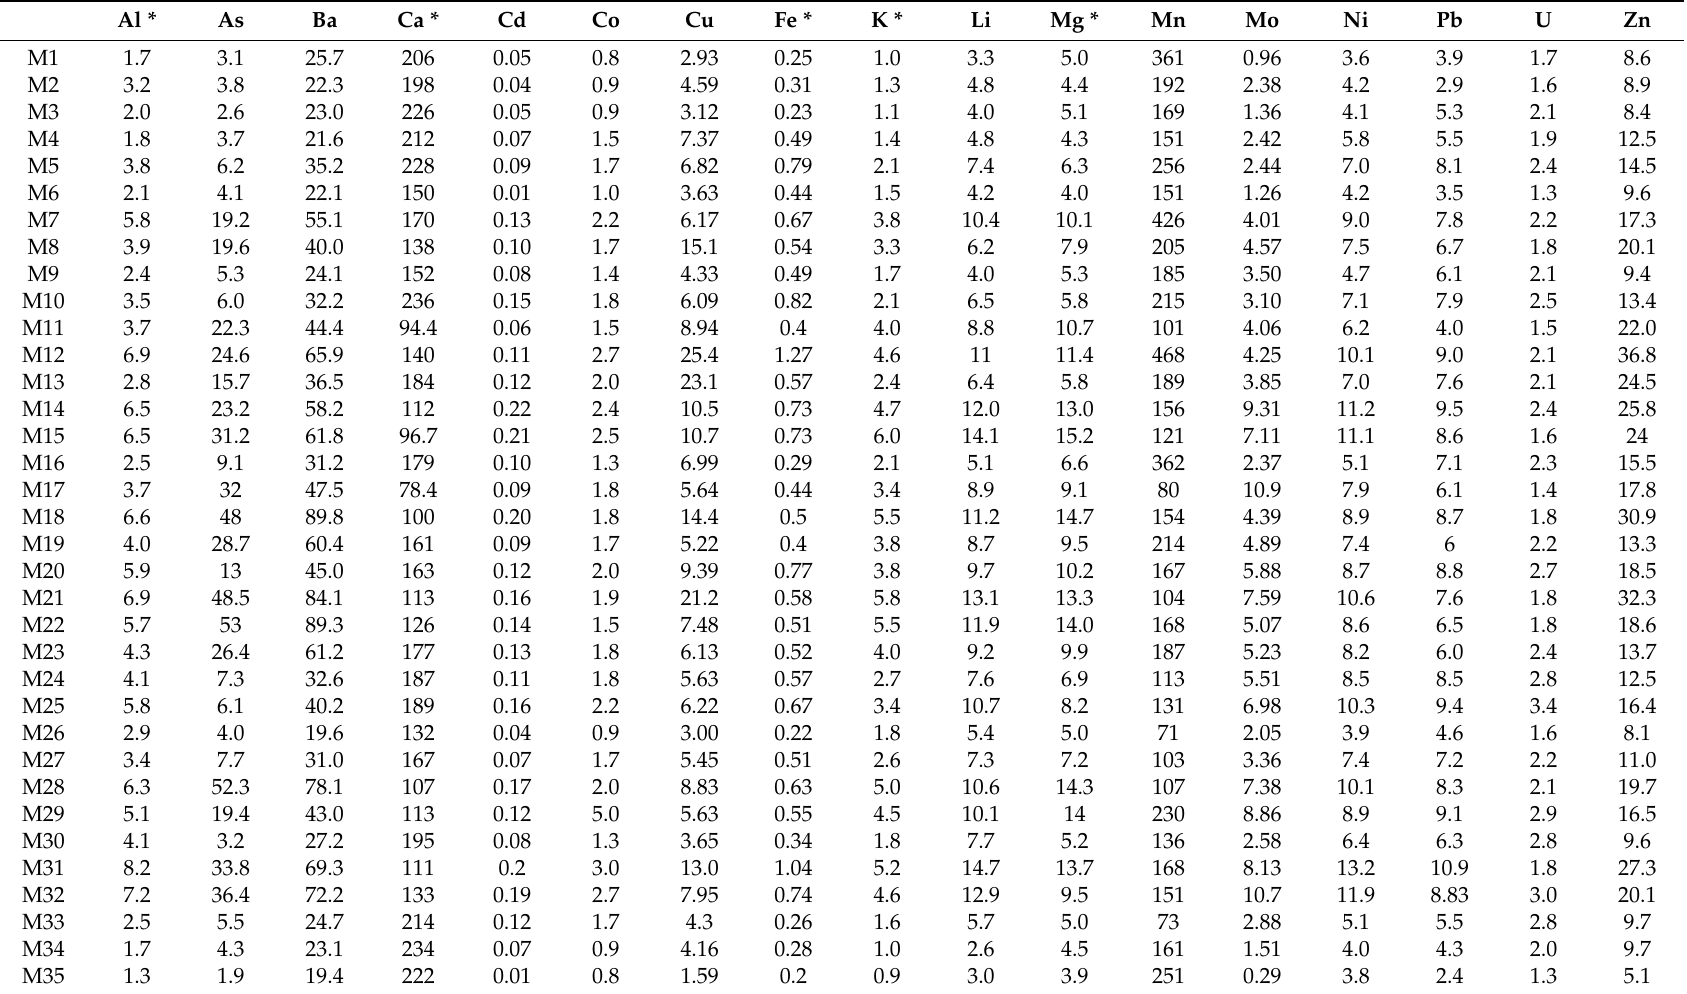
Table A2. Element concentrations, expressed in mg kg − 1 or * g kg − 1 , in the Lake Mir sediments (M1–M35) previously reported by Mlakar et al.